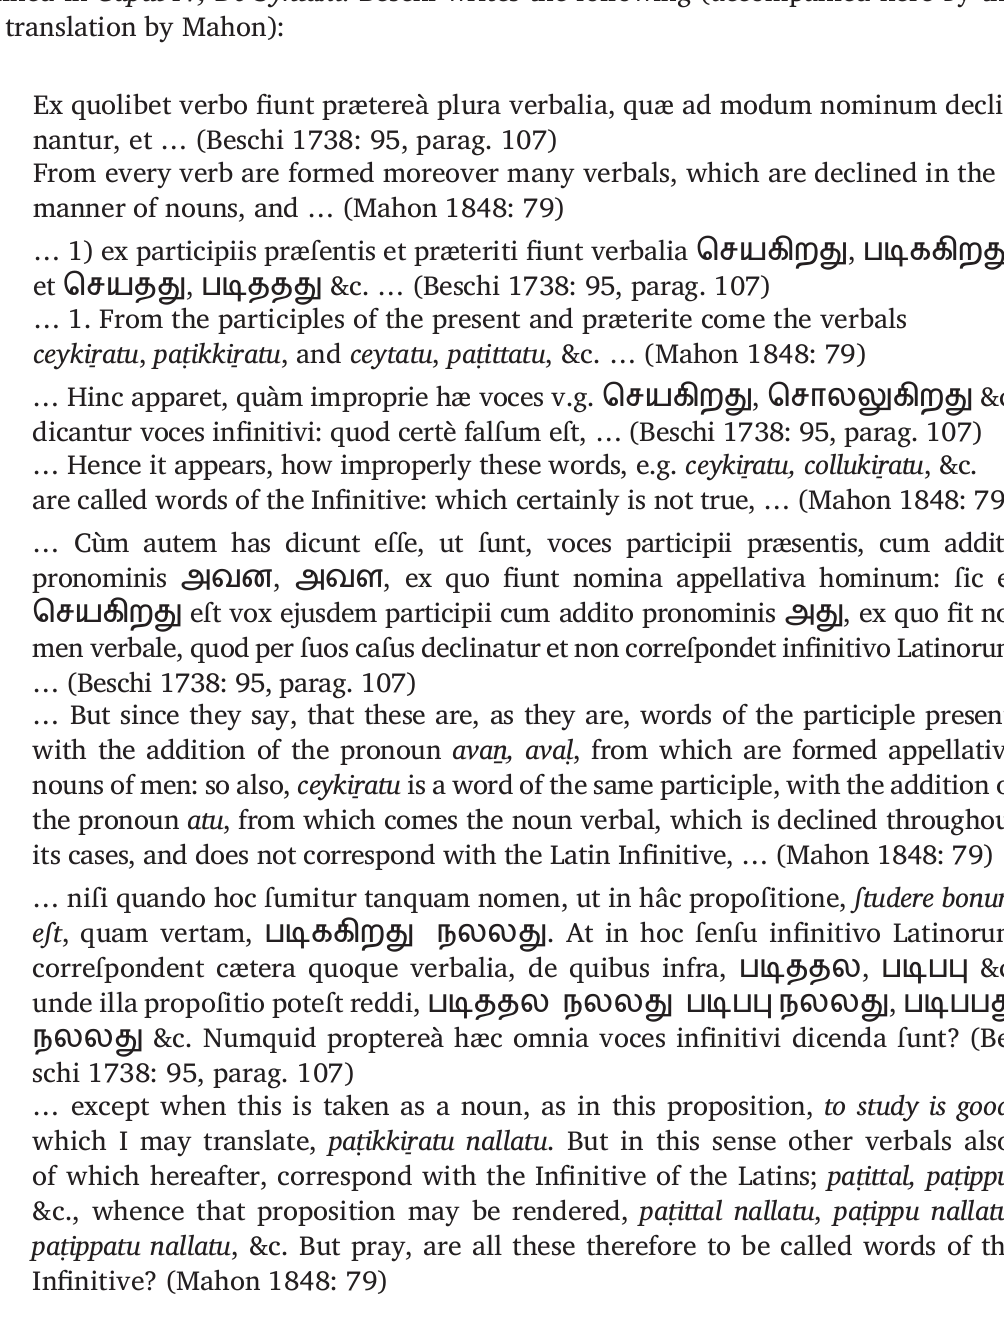
contained in Caput IV, De Syntaxi . Beschi writes the following (accompanied here by the 1848 translation by Mahon):